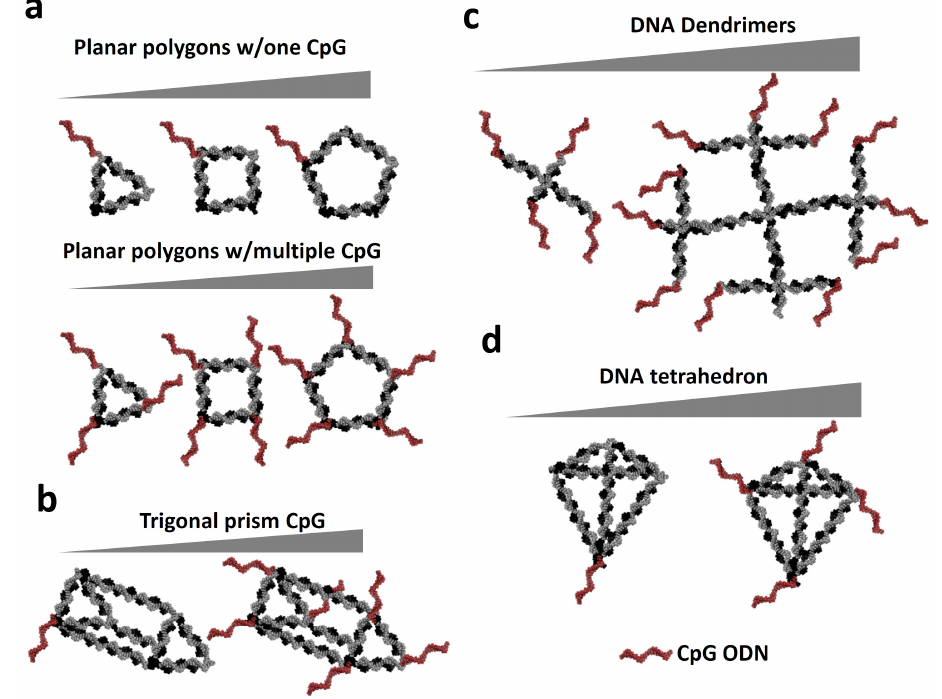
Figure 4. General trend of cytokine release by NANPs. The cytokine induction increase was observed by different cytosine-phosphate-guanosine (CpG) carriers including planar polygonal 2 ′ -f modified NPs ( a ) 2 ′ f modified RNA triangular prisms ( b ) RNA and DNA dendrimeric nanostructures ( c ) and DNA tetrahedrons ( d ).